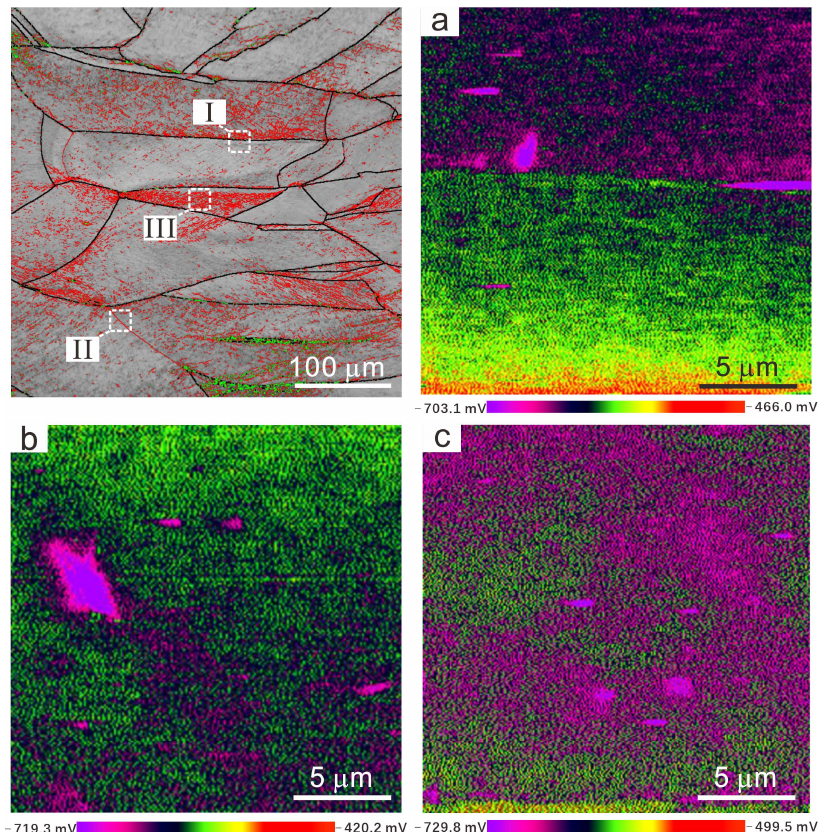
Figure 8. The low-angle grain boundary distribution and the Volta potential of the selected regions for a copper sample with 30% deformation. In the EBSD image of 30% deformed copper. The Volta potential of regions I, II and III with different grain boundary distribution were measured to obtain the corresponding potential distribution maps ( a ), ( b ) and ( c ).